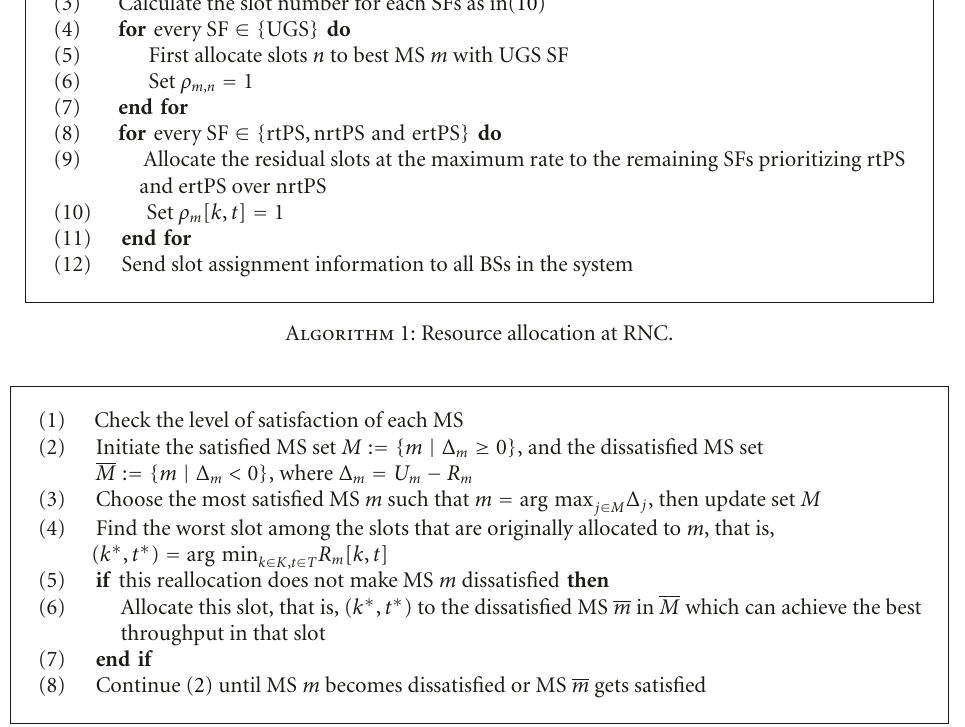
Algorithm 2: Resource allocation at BS.